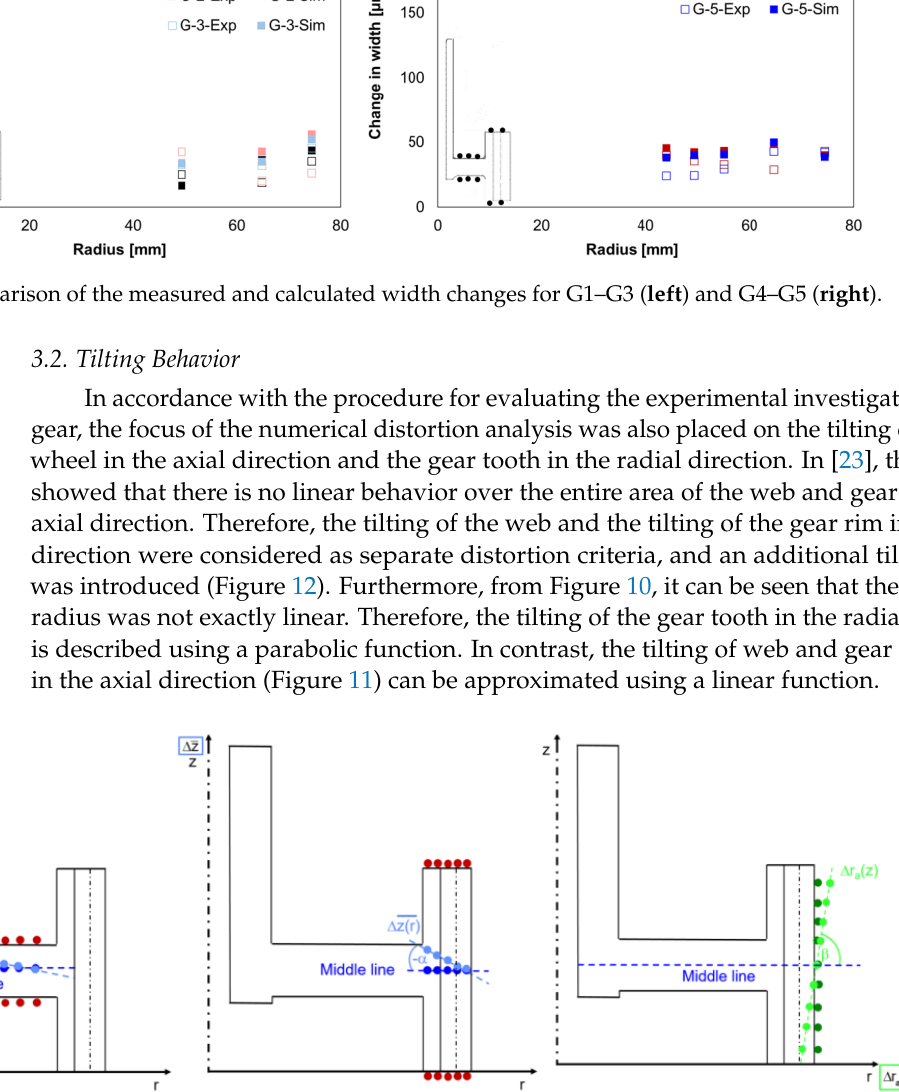
Figure 10. Comparison of the measured and calculated radius changes at the gear tooth for G1–G3 ( left ) and G4–G5 ( right ).